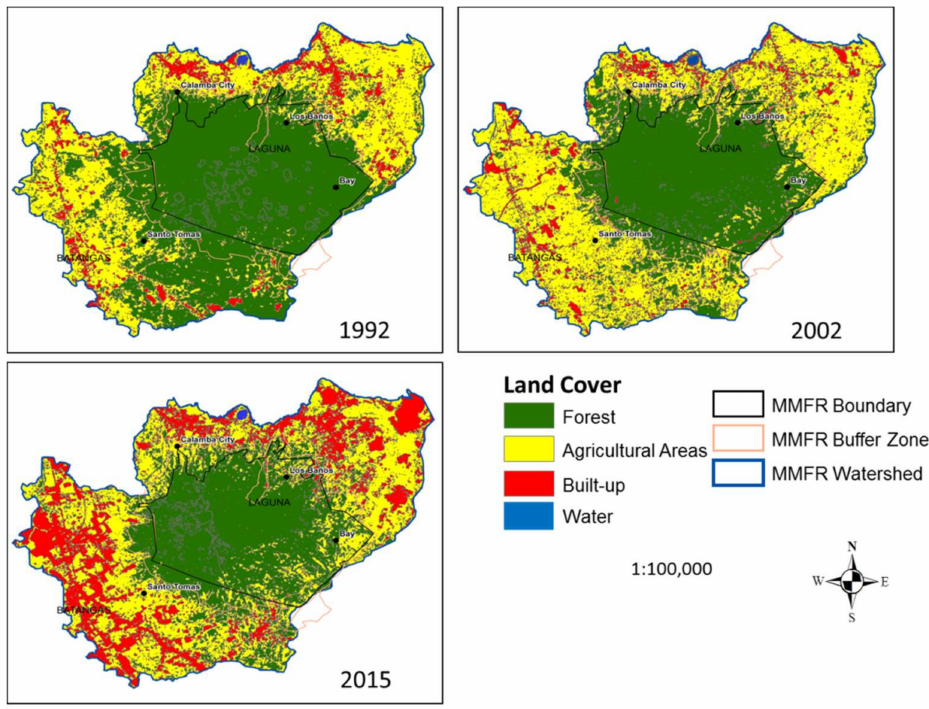
Figure 4. Land Cover Maps of MMFR Watersheds in 1992, 2002 and 2015 generated using the Supervised Classification Approach.